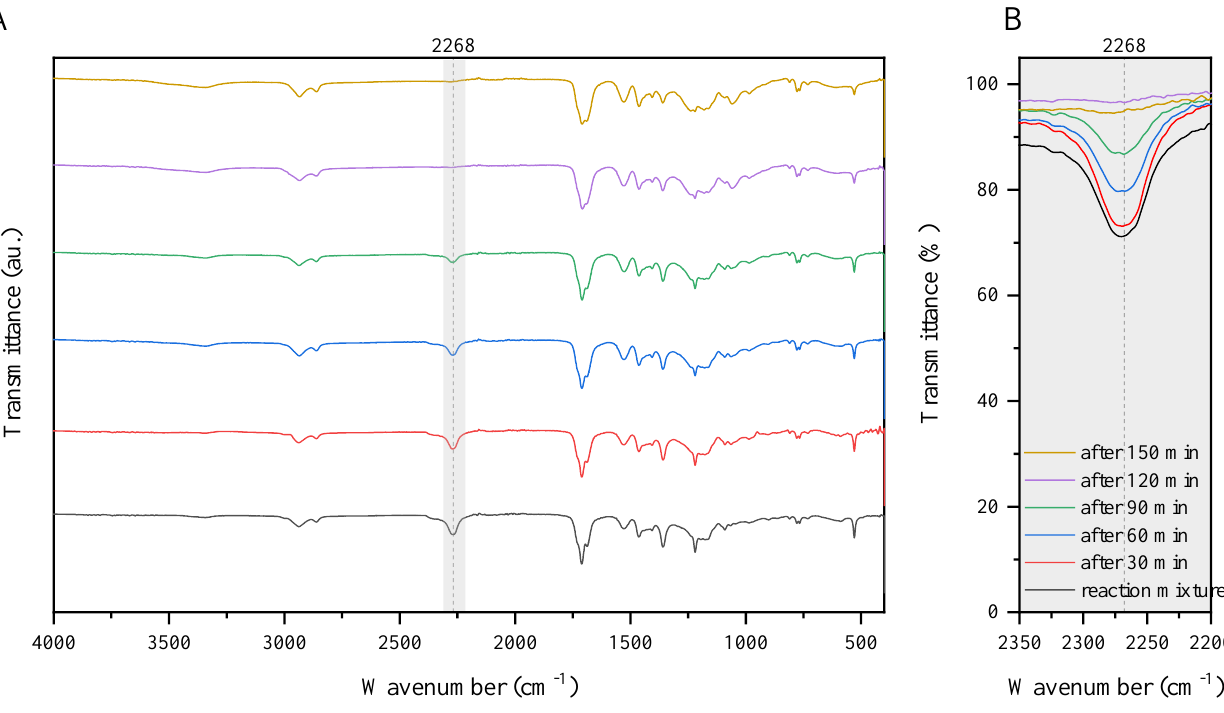
Figure 3. FTIR spectra of 1DB-UA-A prepolymers collected throughout the reaction time ( A ) and monitoring of the disappearance of the peak corresponding to the isocyanate groups ( B ).